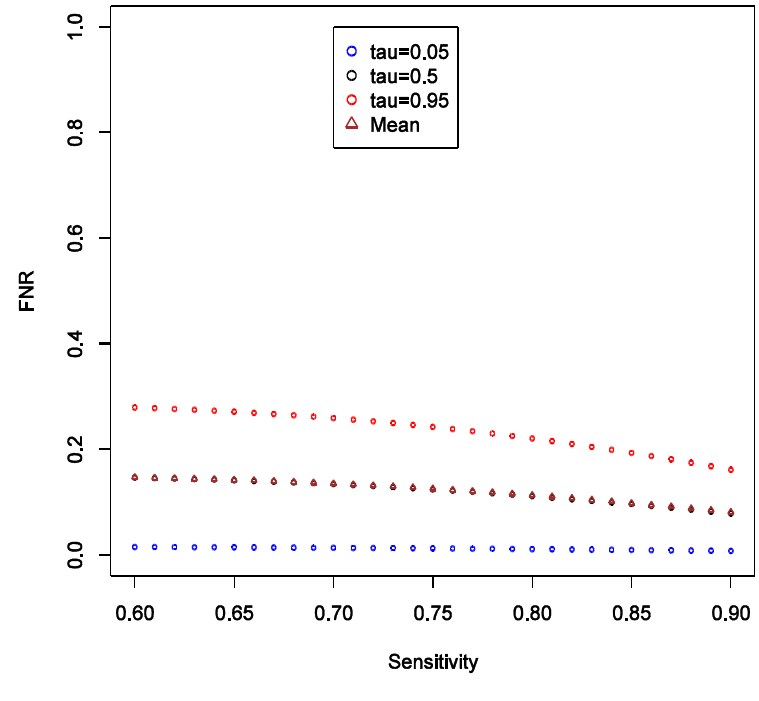
Figure 8. Theoretical calculations of the impact of varying sensitivity of exposure classifier while keeping specificity fixed at 0.5; tau (τ) = expected quintiles of the distribution for false negative rate (FNR); see text for details of other parameter